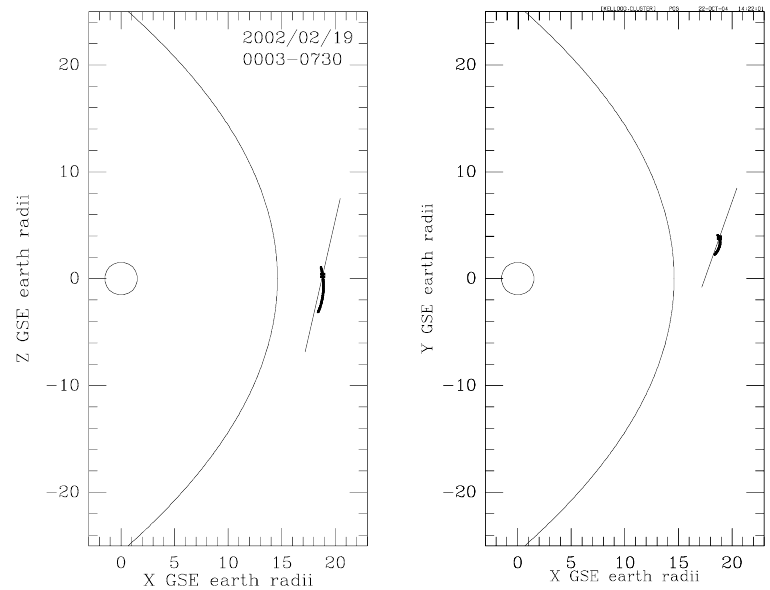
Fig. 1. Spacecraft position during the period chosen for this study, together with a line of magnetic